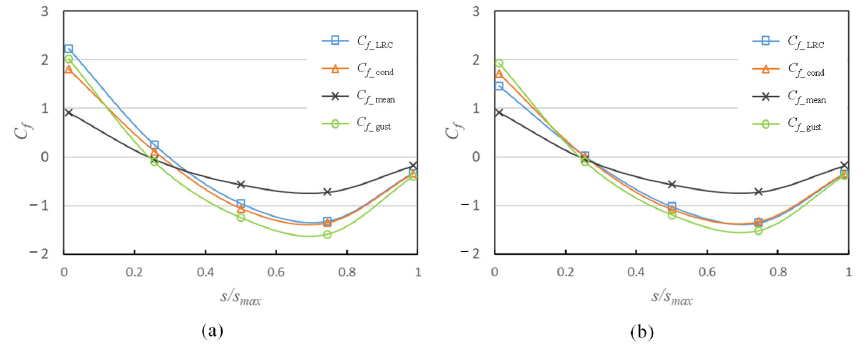
Figure 10. Distributions of equivalent static wind force coefficients providing the maximum load effects: ( a ) Bending moment 𝑀 ; ( b ) axial force 𝑁 .